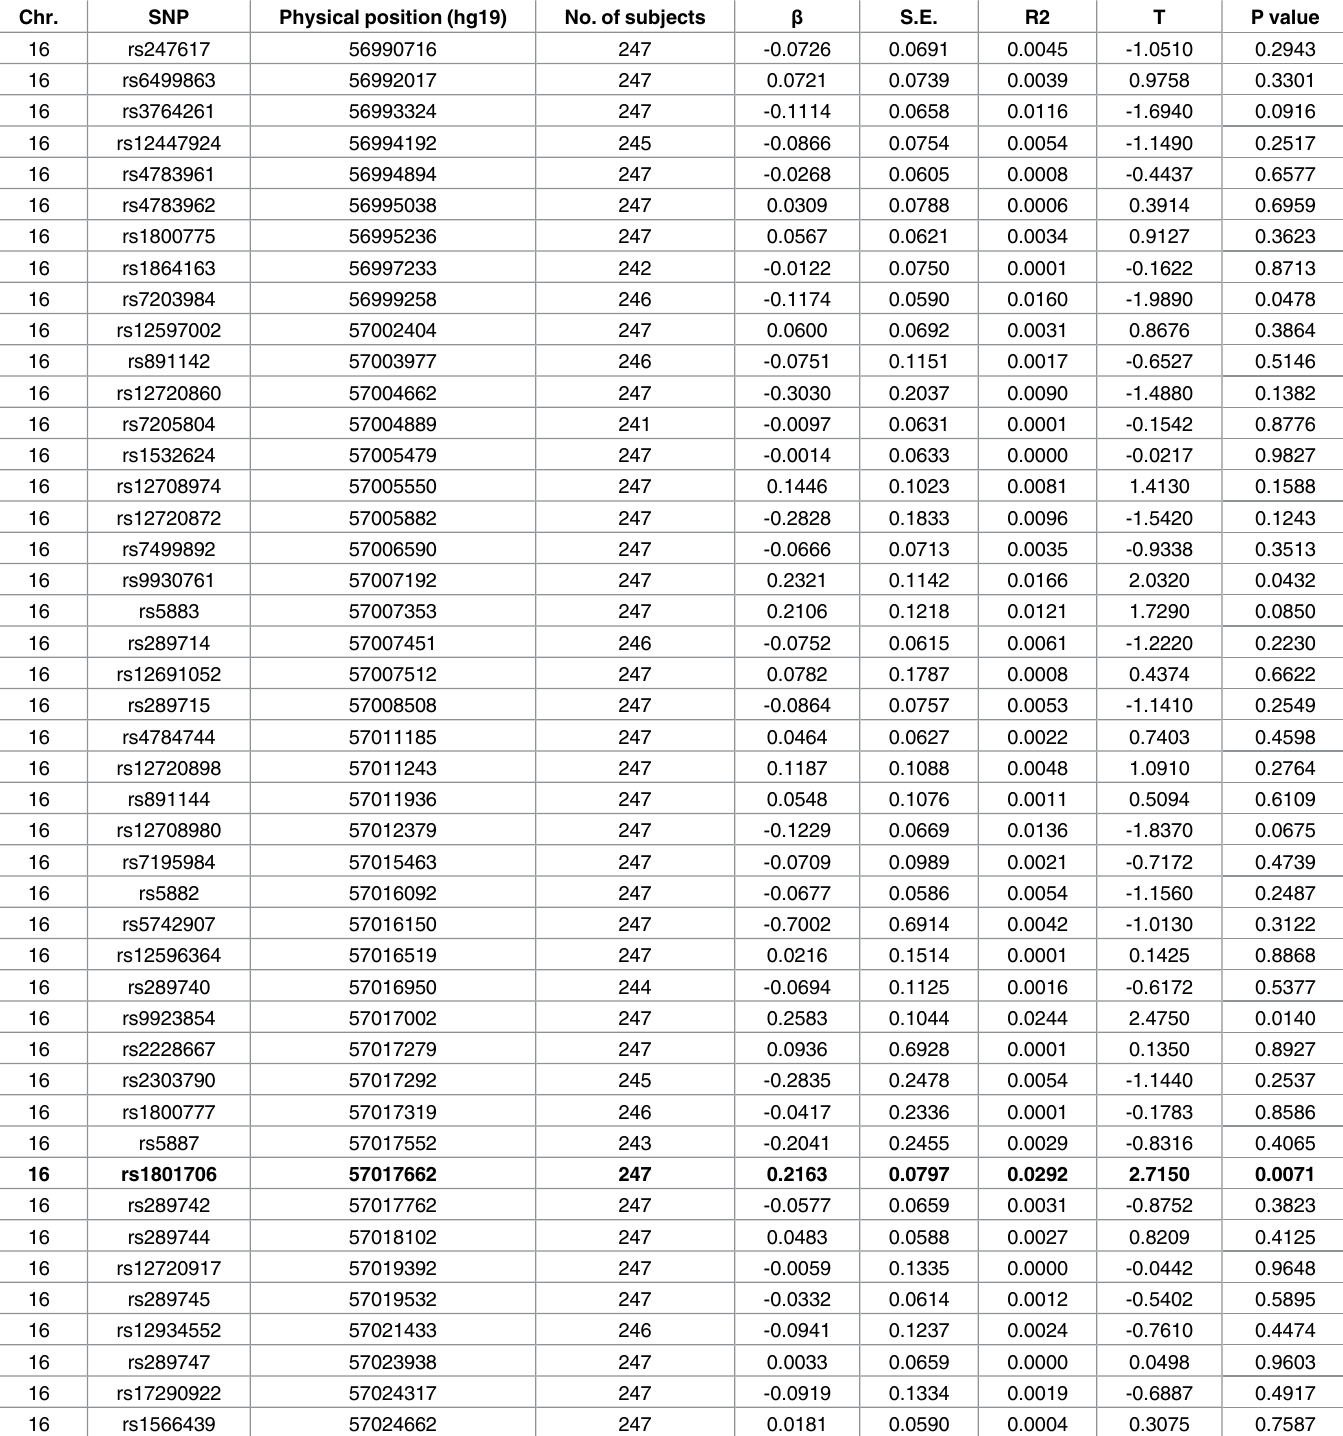
Table 4. SNPs present within ± 10kb of CETP and their respective association p-value with normalized mRNA expression level. Only rs1801706 (c. * 84G > A) was significantly associated and highlightedin bold.